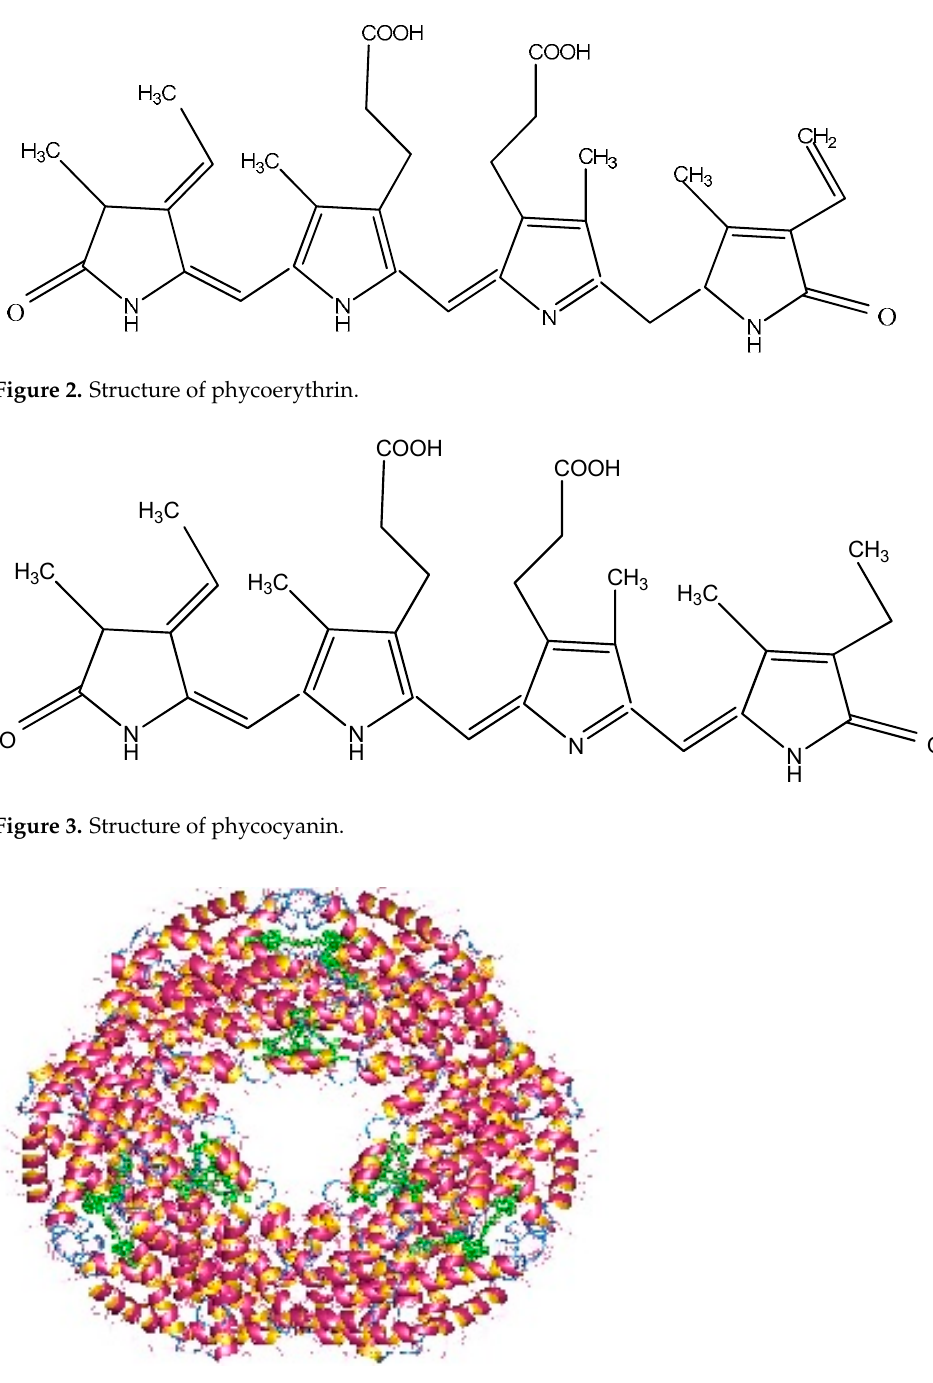
Figure 4. Allophycocyanin dodecamer (available online on https://en.wikipedia.org/wiki/Allophy- cocyanin, accessed on 14 November